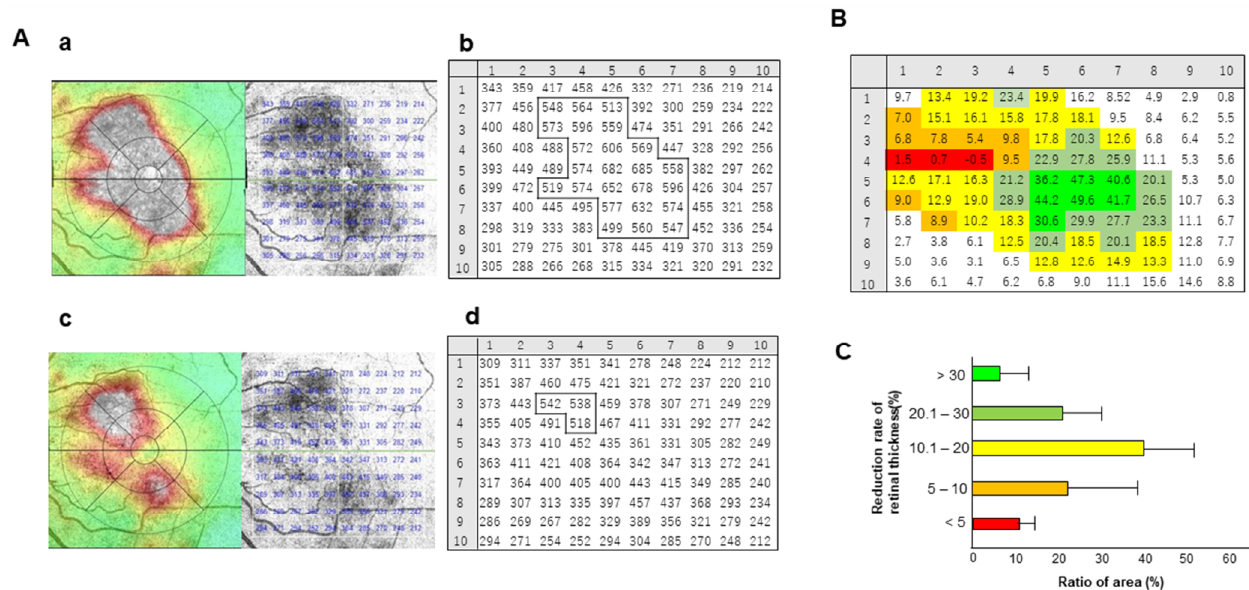
Figure 1. Changes in CRT and BCVA after injection of anti-VEGF agents. CRT ( A ) and BCVA ( B ) were measured 0 and 1 month after a single injection. BCVA is expressed as logMAR. Data are presented as mean ± standard deviation (SD). * p < 0.05 (versus baseline). CRT, central retinal thickness; BCVA, best-corrected visual acuity; VEGF, vascular endothelial growth factor; SD, standard deviation.